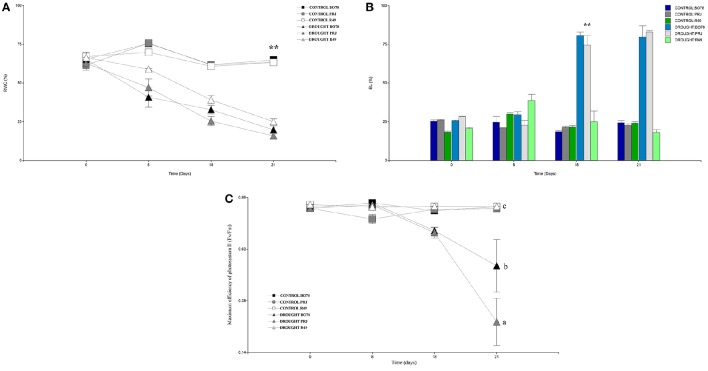
Physiological performance of quinoa genotypes in days under drought conditions. (A) Percentage of Relative water content (RWC). (B) Percentage of Electrolytic leakage (EL). (C) Maximum efficiency of photosystem II (Fv/Fm). X-axis represents days under drought. RWC was measured based in the plant total weight that corresponded to water; EL represents the percentage of ions that were released compared to total amount present in the plant; Fv/Fm represents the capacity for photon energy absorbed by photosystem II (PSII) to be utilized in photochemistry under dark- and light-adapted conditions. Values and Bars represent averages and standard deviation (n = 3); ** and different letters denote significant differences (p < 0.01 and p < 0.05 respectively).